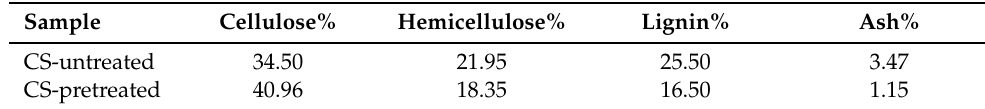
Table 1. Composition analysis of untreated and pretreated corn